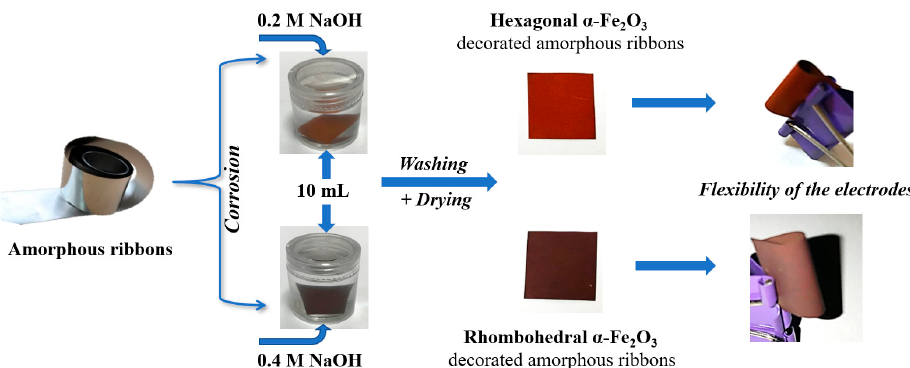
Figure 1. Schematic illustration of the one-step synthesis process of the fl exible electrode.